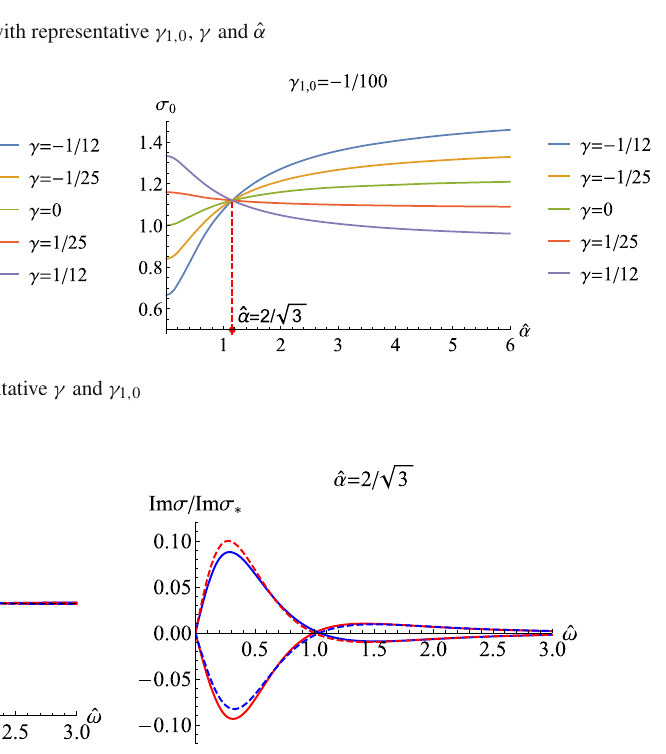
Fig. 11 The optical conductivity as a function of ˆ ω for various values √ of γ , γ 1 , 0 and fixed ˆ α = 2 / 3. The solid and dashed curves are the conductivity of the original EM theory and its dual theory, respectively